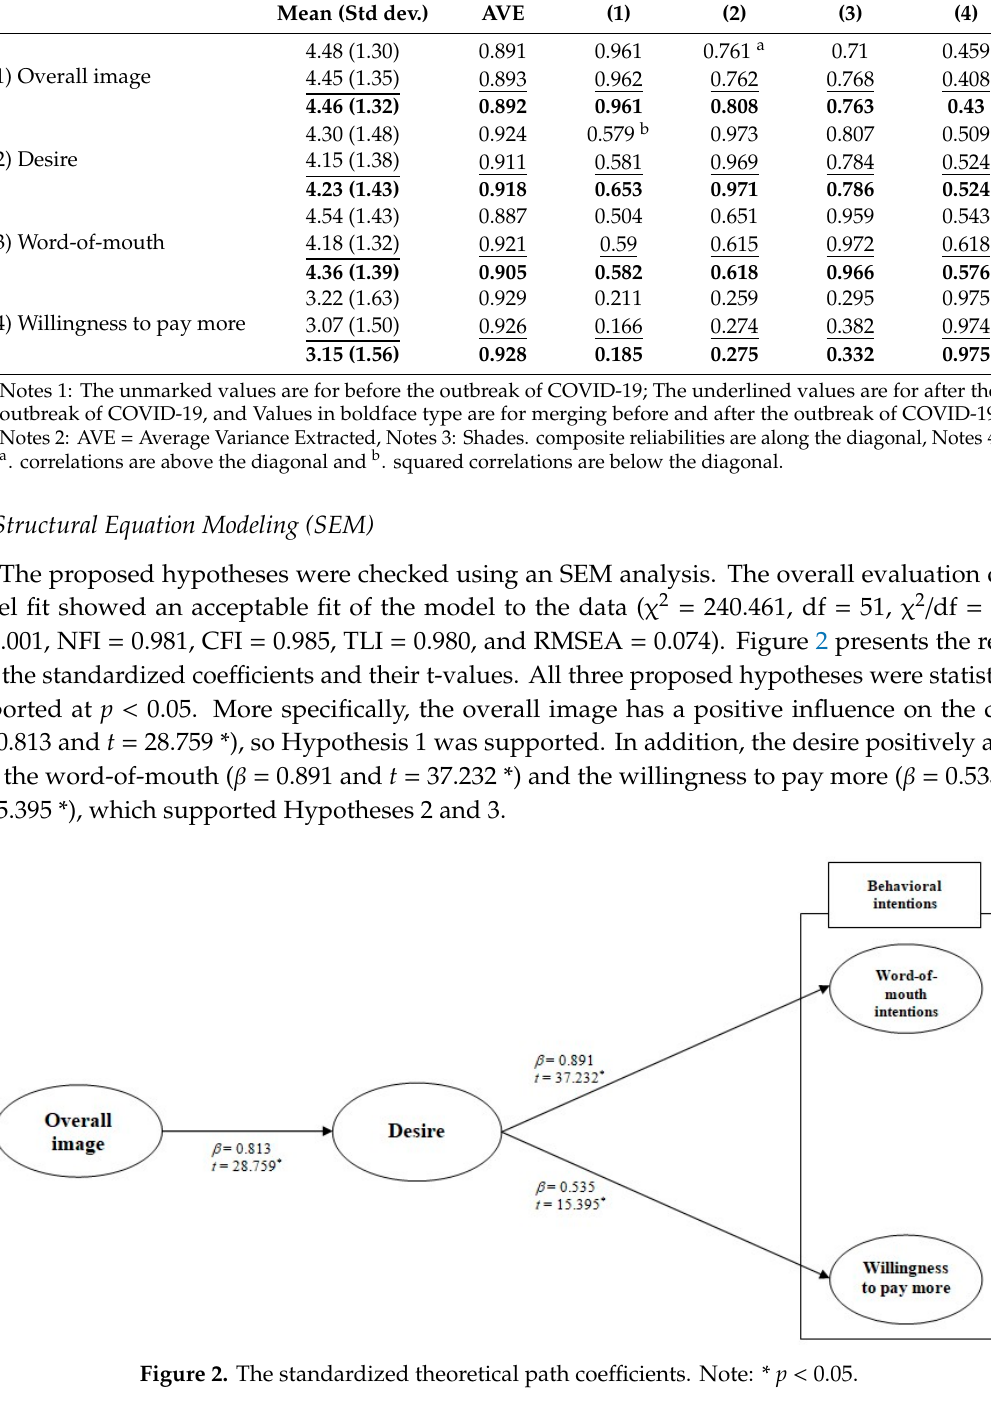
Table 3. The descriptive statistics and the associated measures. Mean (Std dev.) AVE